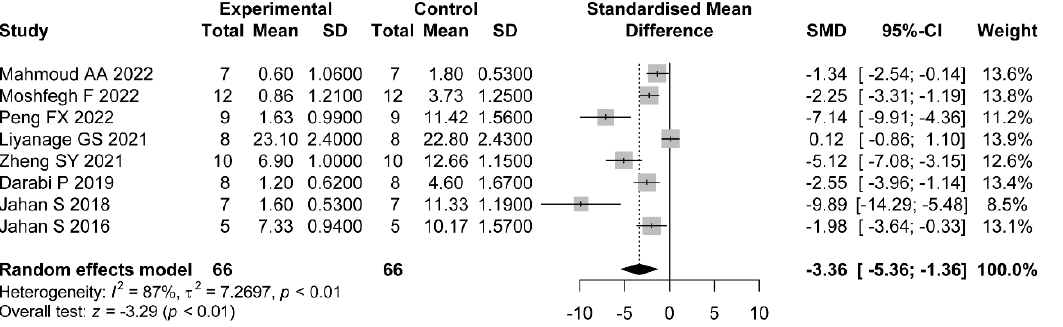
Figure 4. Forest plot of flavonoids for the count of cystic follicles.